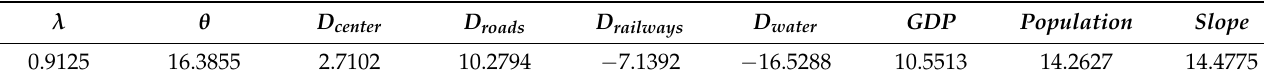
Table 2. The CA parameters obtained by SAR.